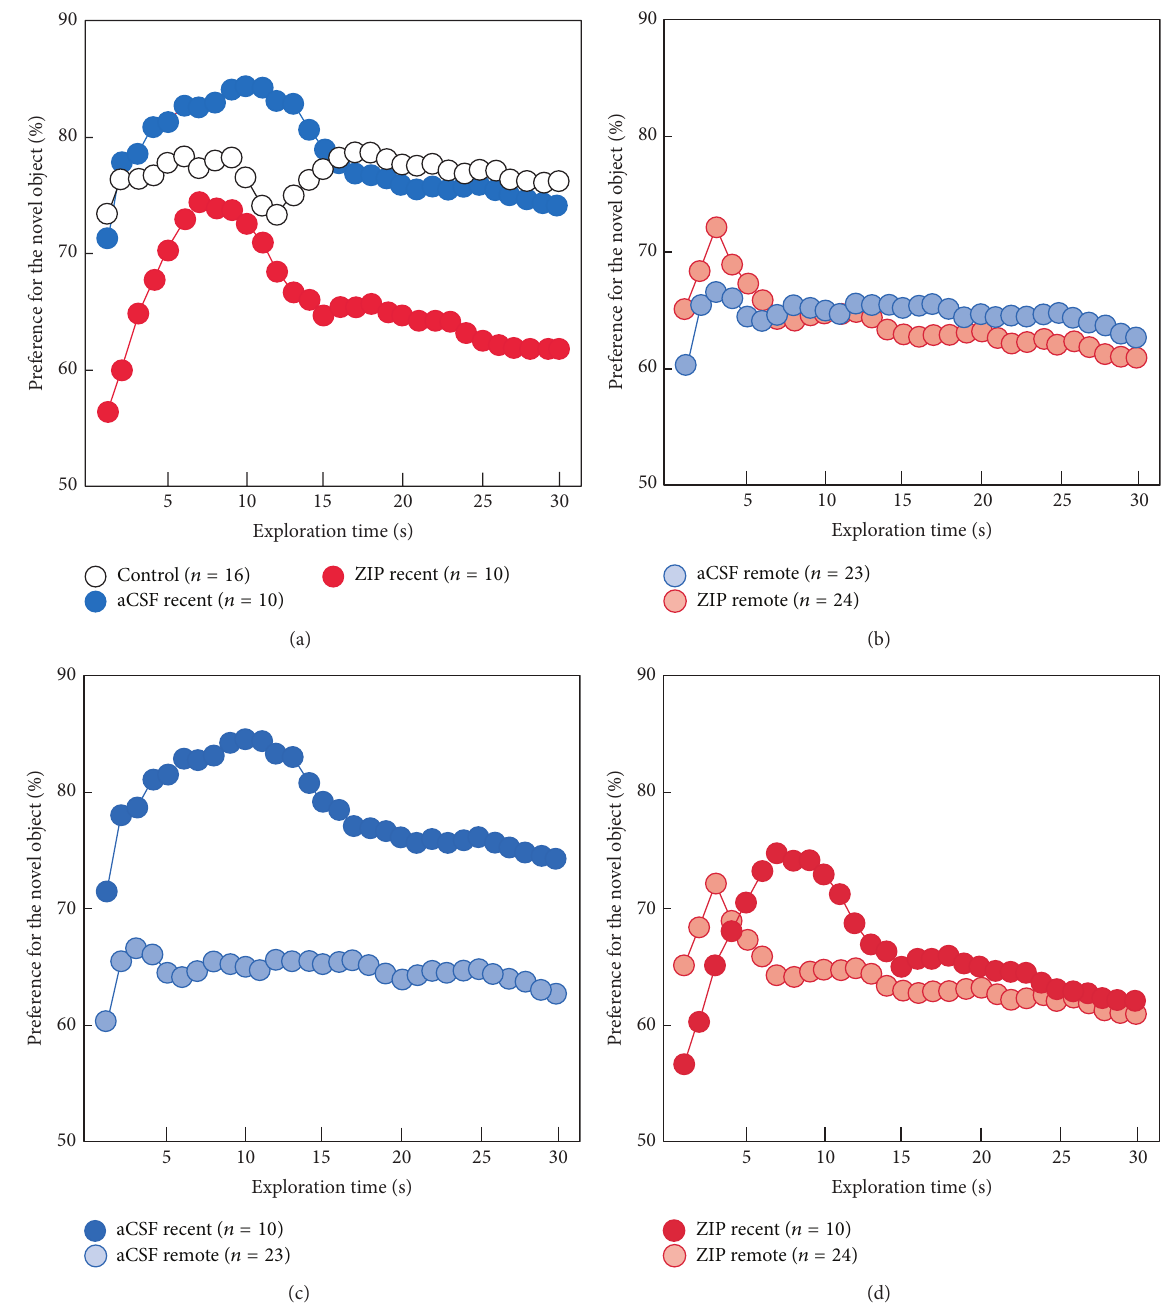
Figure 3: Cumulative percent preference for the novel objects across 30 sec of object exploration for the three groups in the recent condition (a), the two groups in the remote condition (b), the recent and remote aCSF groups (c), and the recent and remote ZIP groups (d). The pattern of performance indicates that the aCSF recent group and the unoperated control group showed a stronger preference for the novel object across the entire 30 sec test than the ZIP recent, ZIP remote, or aCSF remote